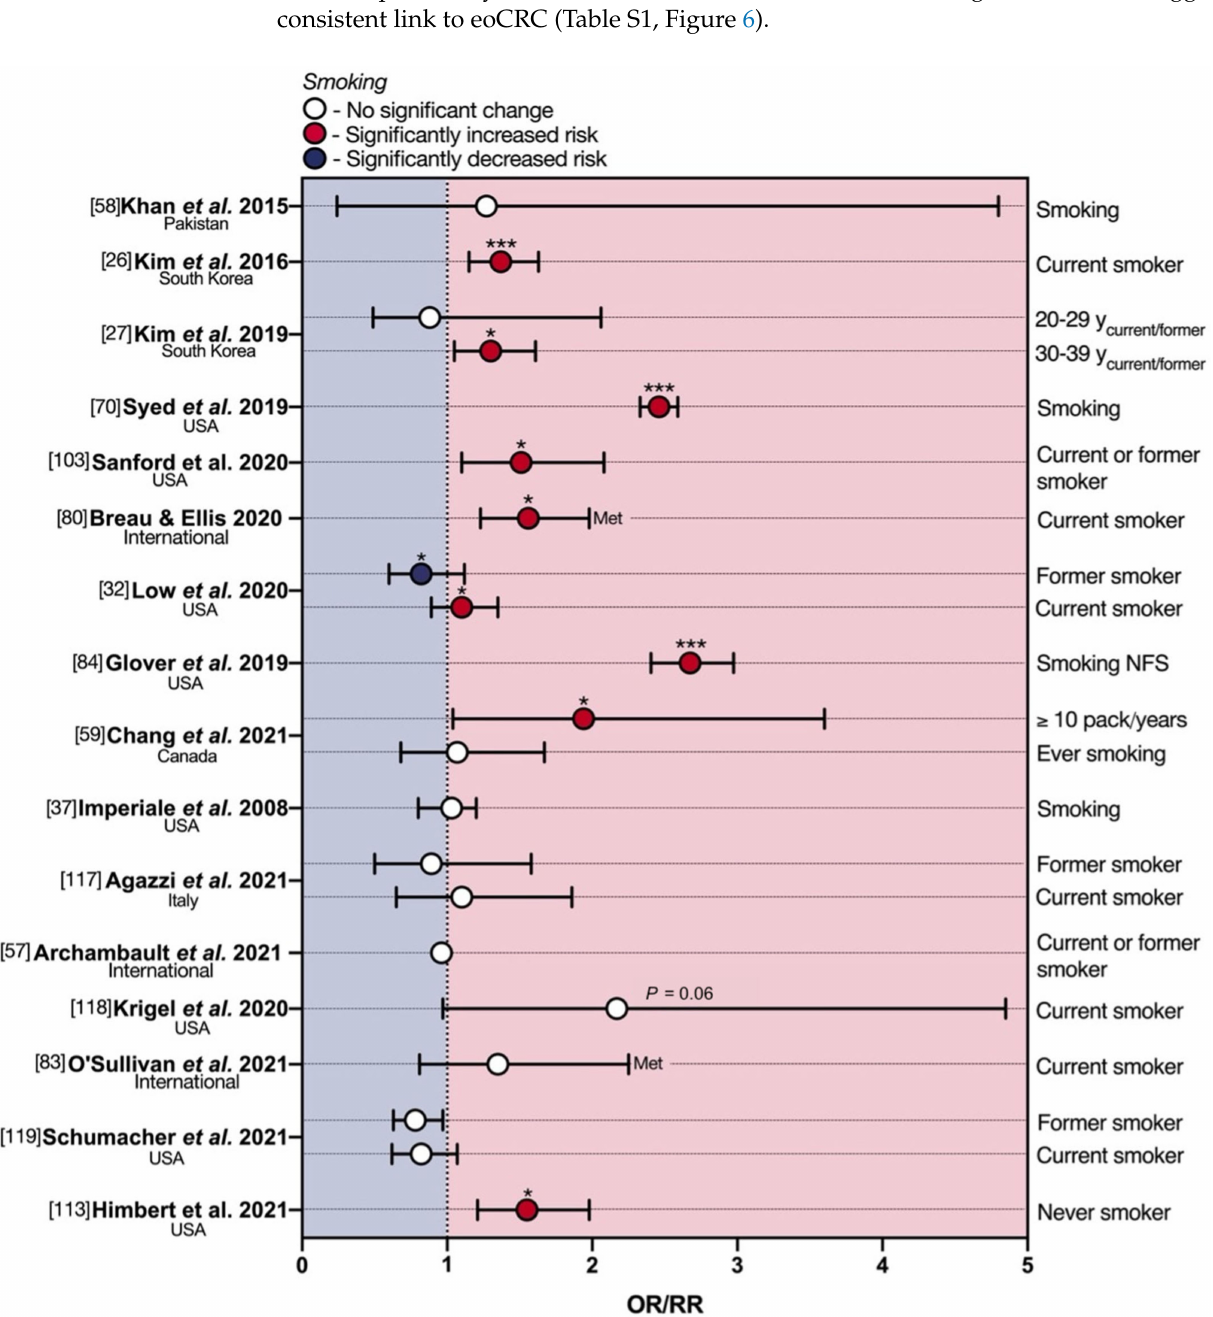
Figure 6. Protective and deleterious effects of smoking in early-onset colorectal cancer. eoCRC—early-onset colorectal cancer; Met—meta-analysis; NFS—not further specified; OR—odds ratio; RR—relative risk. * p < 0.05; *** p <